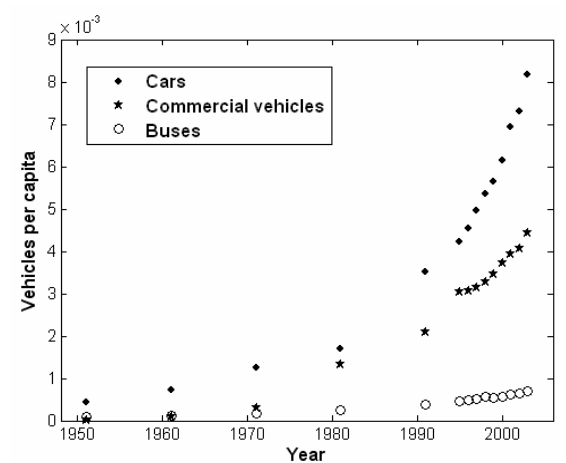
Fig 8. Variation of yearly vehicle ownership and GDP per capita